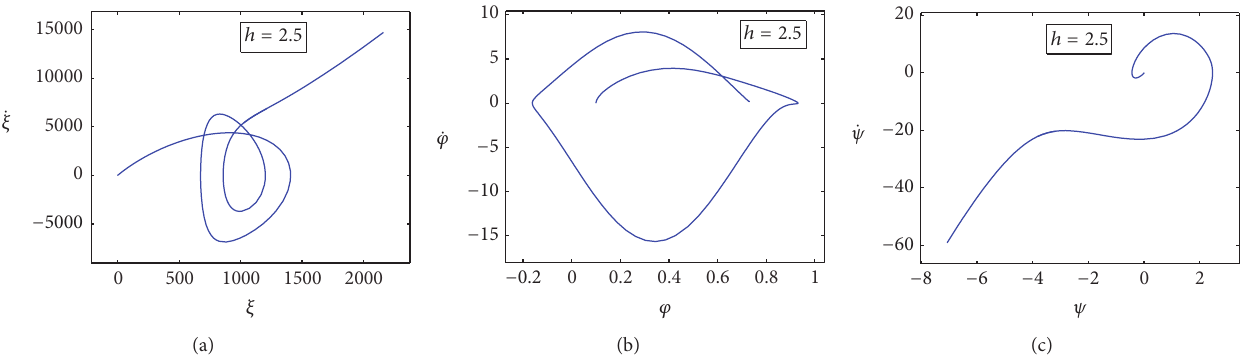
Figure 10: The phase plane diagrams which portray the relation between amplitudes and their velocities at 𝑏 = 3 m, ℎ = 2.5 , 𝑎 = 0.5 m, and = 0.4 rad: (a) describes the influence of 𝜉 on ̇𝜉 , (b) shows the effect of 𝜑 on ̇𝜑 , and (c) illustrates the variation of 𝜓 with ̇𝜓 . 𝜑 0